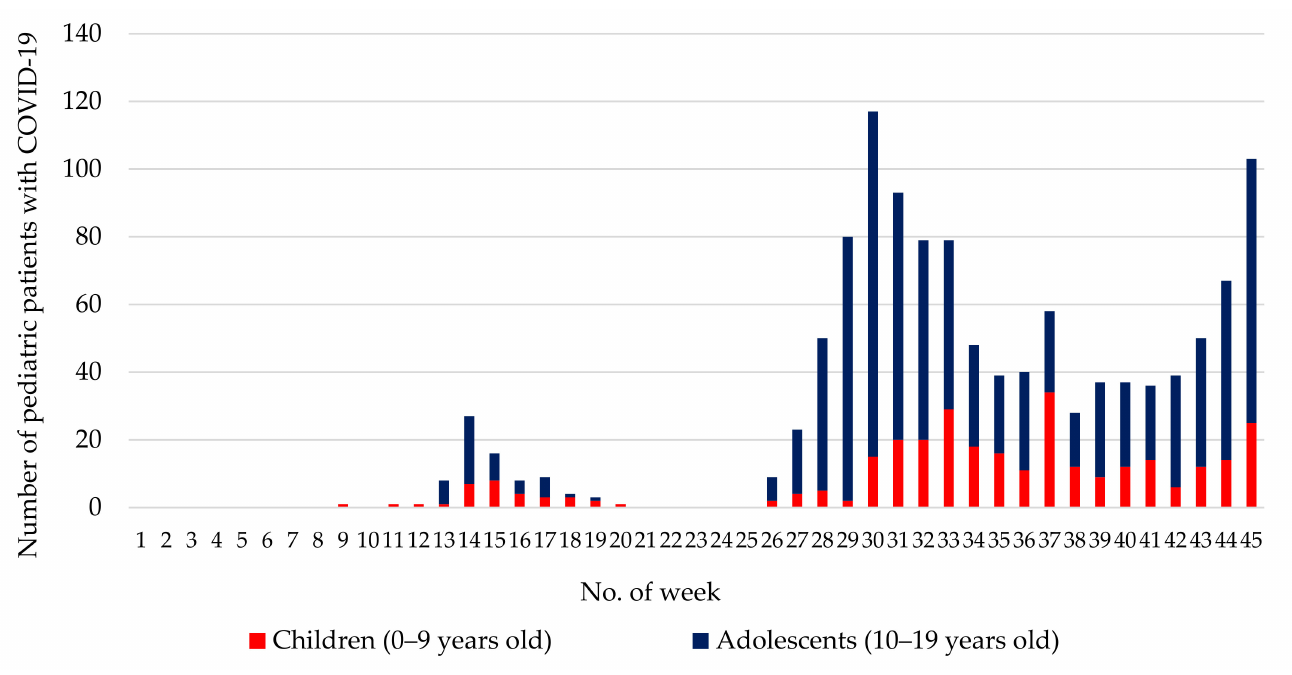
Figure 2. Weekly number of pediatric COVID-19 patients. A data collection system managed by Osaka Prefecture was used until October, 2020. This system was used with the government-recommended one in November 2020 and has been fully integrated into the government-recommended system since December 2020; therefore, not all cases in November 2020 were registered.